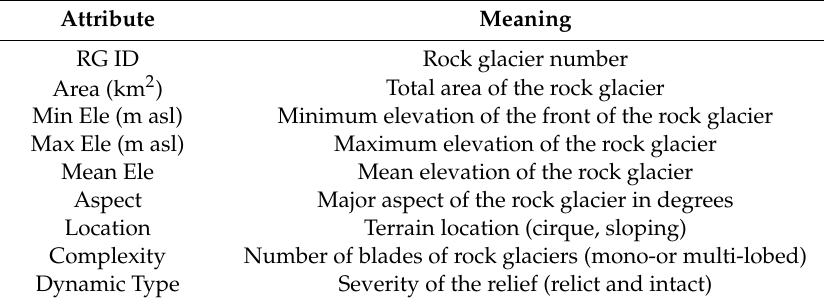
Table 1. Attributes derived for the inventory of the rock glaciers. Attribute Meaning RG ID Rock glacier number Area (km 2 ) Total area of the rock glacier Min Ele (m asl) Minimum elevation of the front of the rock glacier Max Ele (m asl) Maximum elevation of the rock glacier Mean Ele Mean elevation of the rock glacier Aspect Major aspect of the rock glacier in degrees Location Terrain location (cirque, sloping) Complexity Number of blades of rock glaciers (mono-or multi-lobed) Dynamic Type Severity of the relief (relict and